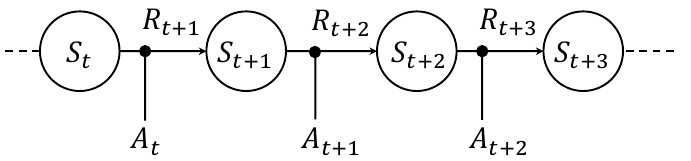
Figure 1. Markov decision process from the reinforcement learning perspective: each node represents state S , A t + i denotes action A , and R t + i denotes reward R